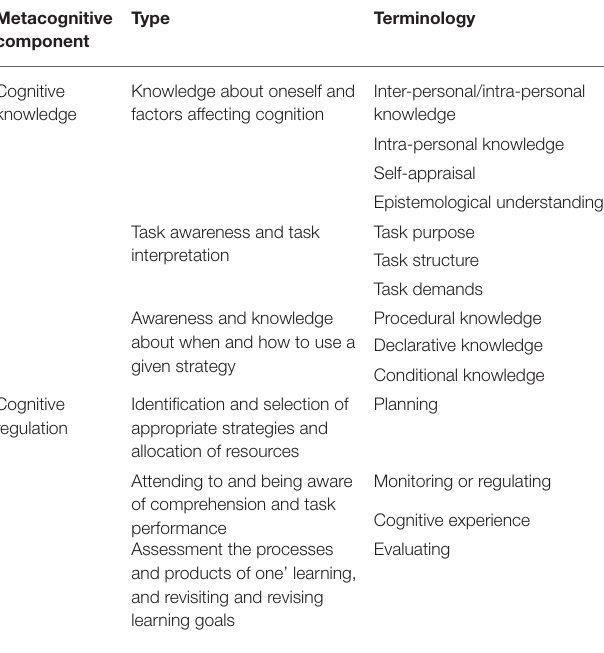
TABLE 1 | Theoretical framework of